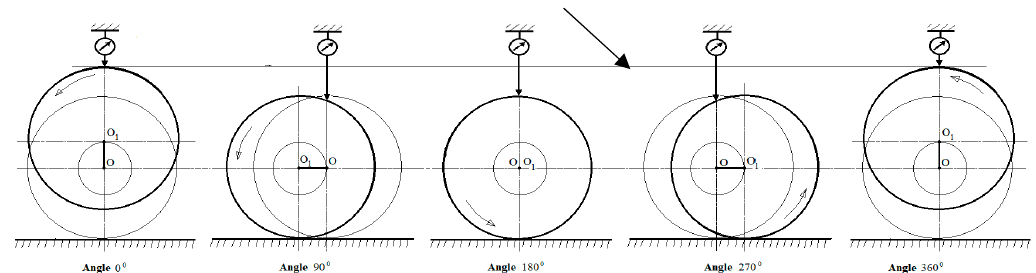
Figure 12. Supplementary diagram of the successive stages of shaft deflection caused by its eccentricity with respect to the axis of rotation of the measuring system when the support retains its fixed